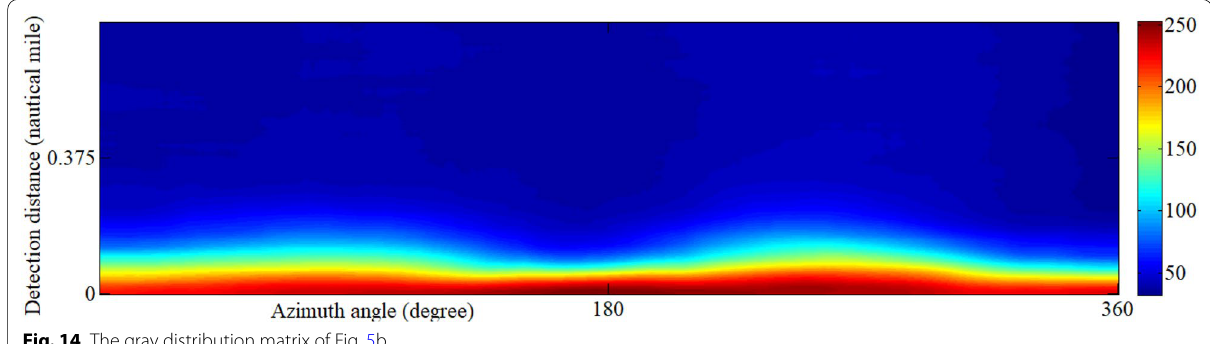
Fig. 14 The gray distribution matrix of Fig.